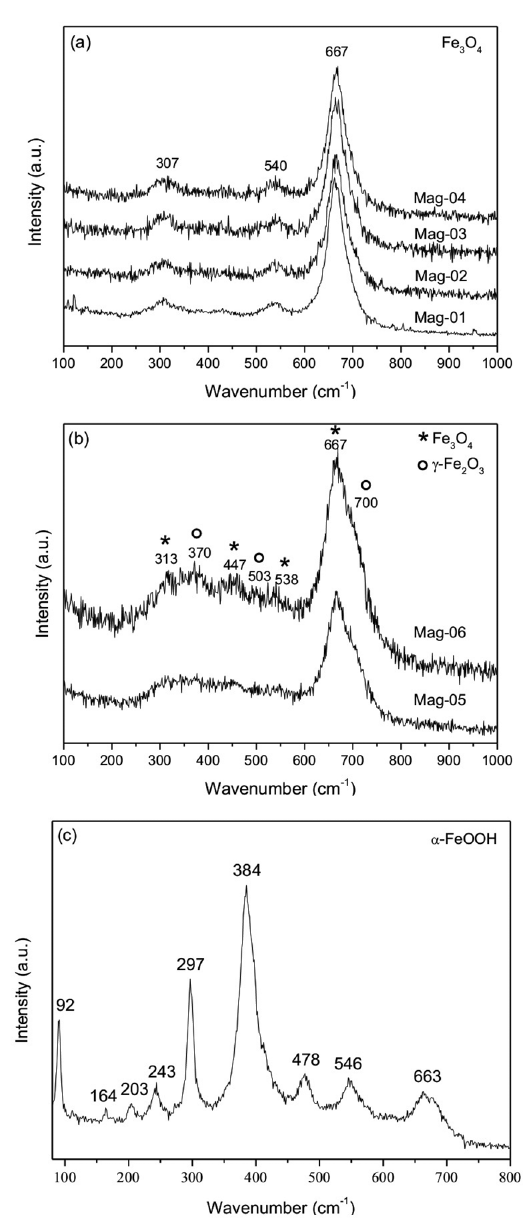
O ) nanoparticles synthesis parameters and properties 3 4